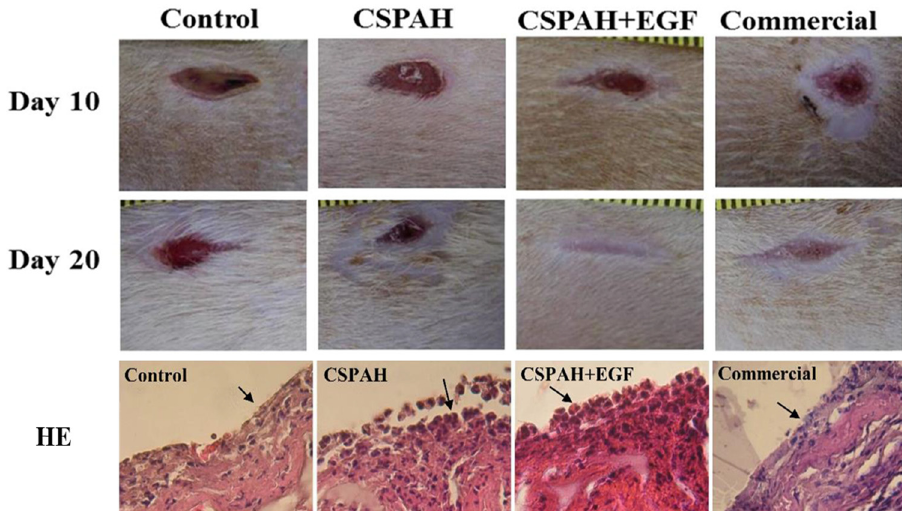
Figure 4: Representative images and HE staining results of wound surface healing over time in CSPAH, CSPAH - incorporating EGF, com - mercial dressings, and the control at days 10 and 20. HEMA: hydroxyethyl methacrylate; CSPAH: chitosan - PAA - pHEMA; EGF: epidermal growth factor; PAA: poly ( acrylic acid ) [ 103 ]